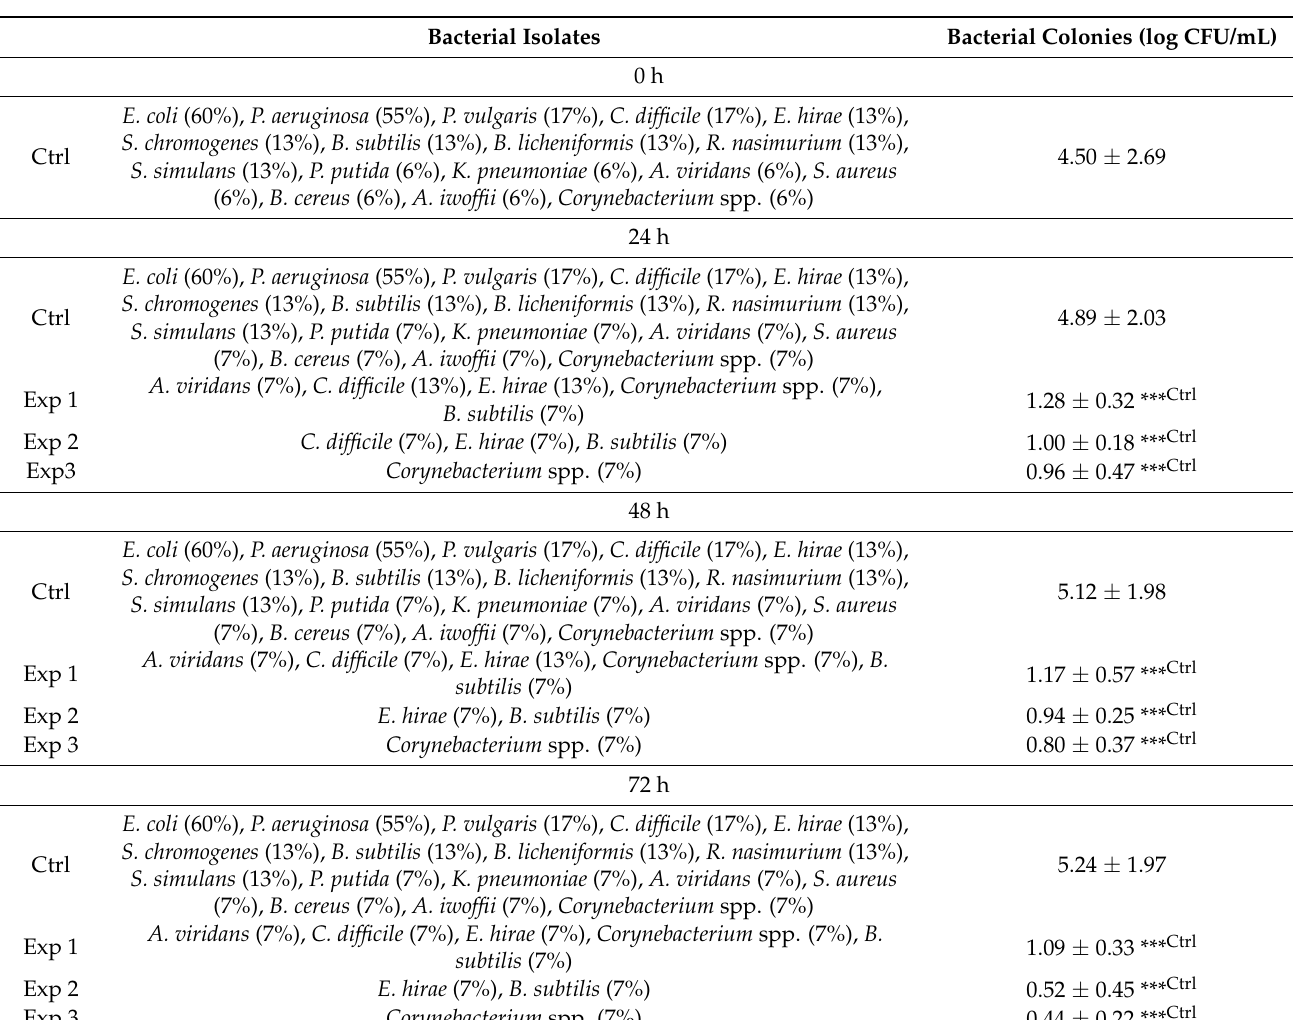
Table 9. Bacteria recovered (% sample positivity) from extended boar semen and identified by MALDI-TOF MS